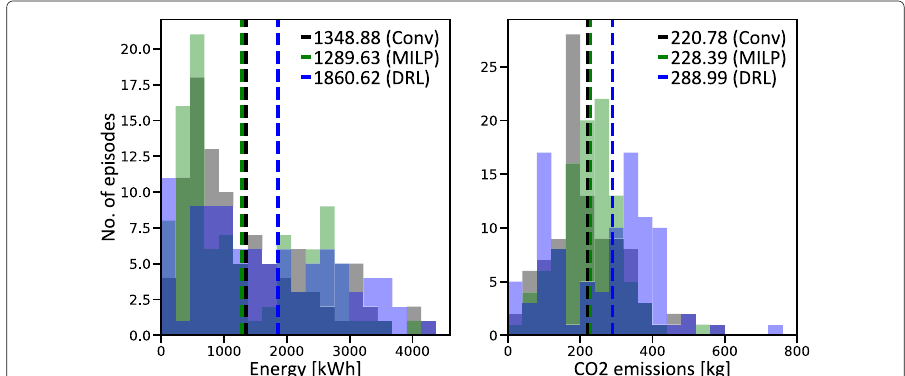
Fig. 10 Distribution and mean value of energy consumption and CO 2 emissions per episode for system A . Black: Conventional controller, Blue: DRL controller, Green: MILP controller